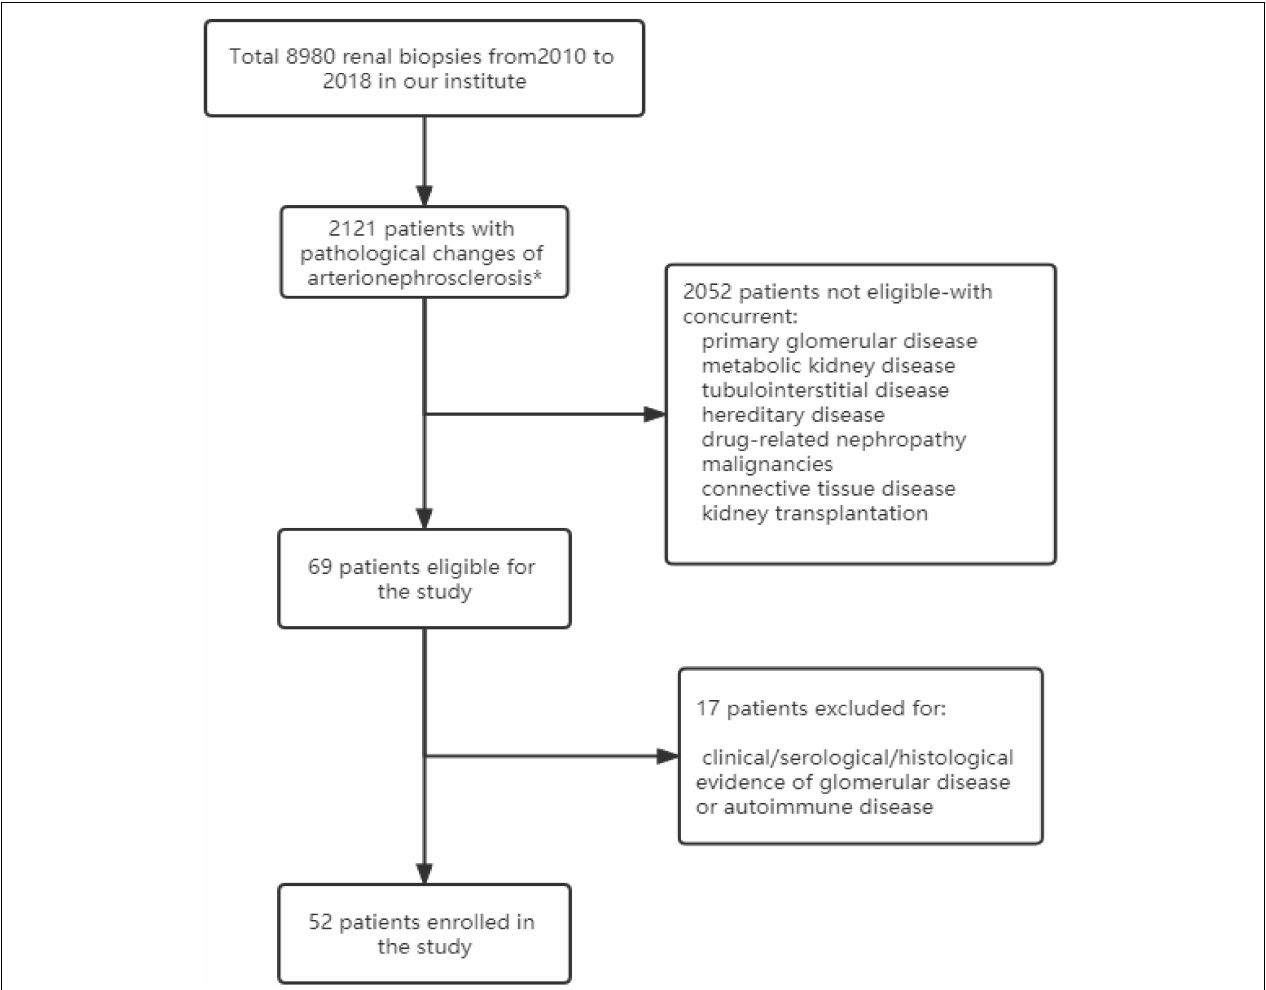
FIGURE 1 | Flow chart of the study. *Vascular lesions with fibromuscular thickening of the intima and media of small arteries and arterioles, glomerulosclerosis, and IFTA (interstitial fibrosis and tubular